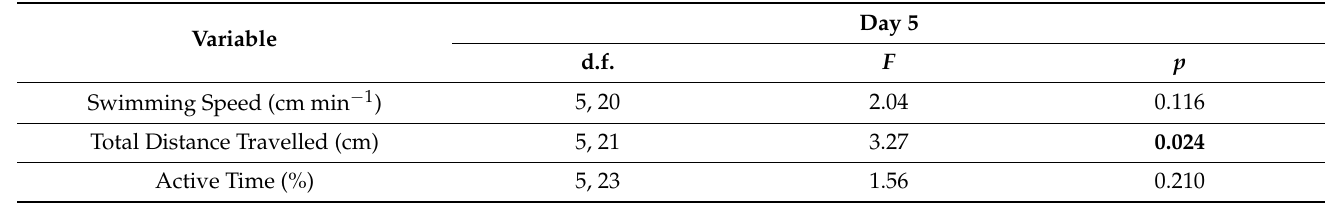
Table 4. Behavioral effects (swimming speed, total distance traveled and active time) on Daph-